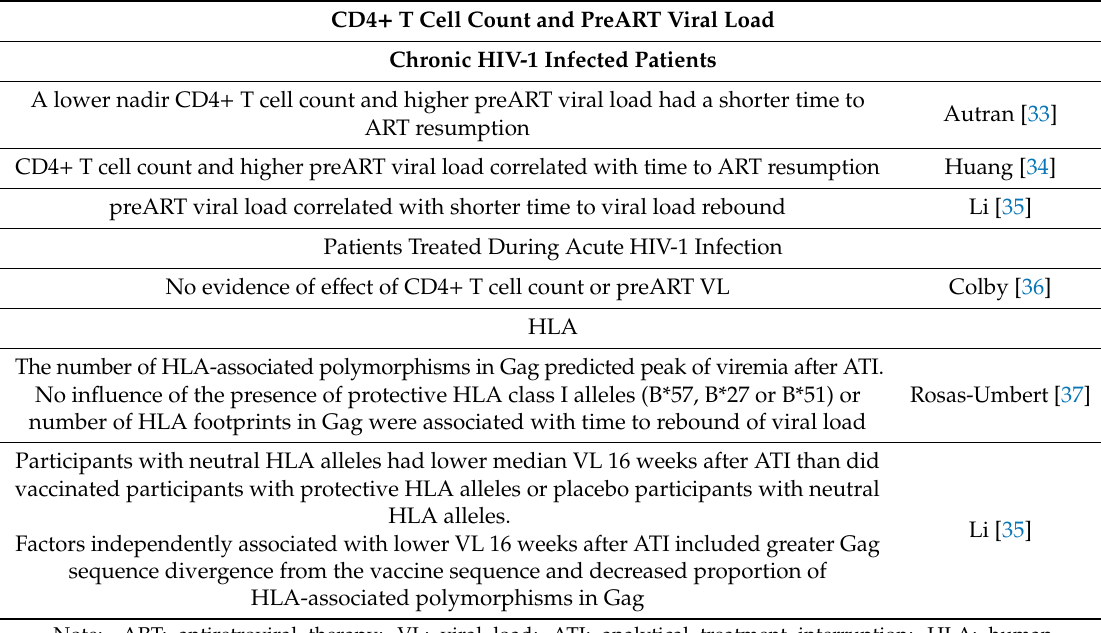
Table 2. Summary of influences of host, viral load, and CD4 + T cell counts on viral load rebound. CD4 + T Cell Count and PreART Viral Load Chronic HIV-1 Infected Patients A lower nadir CD4 + T cell count and higher preART viral load had a shorter time to ART resumption